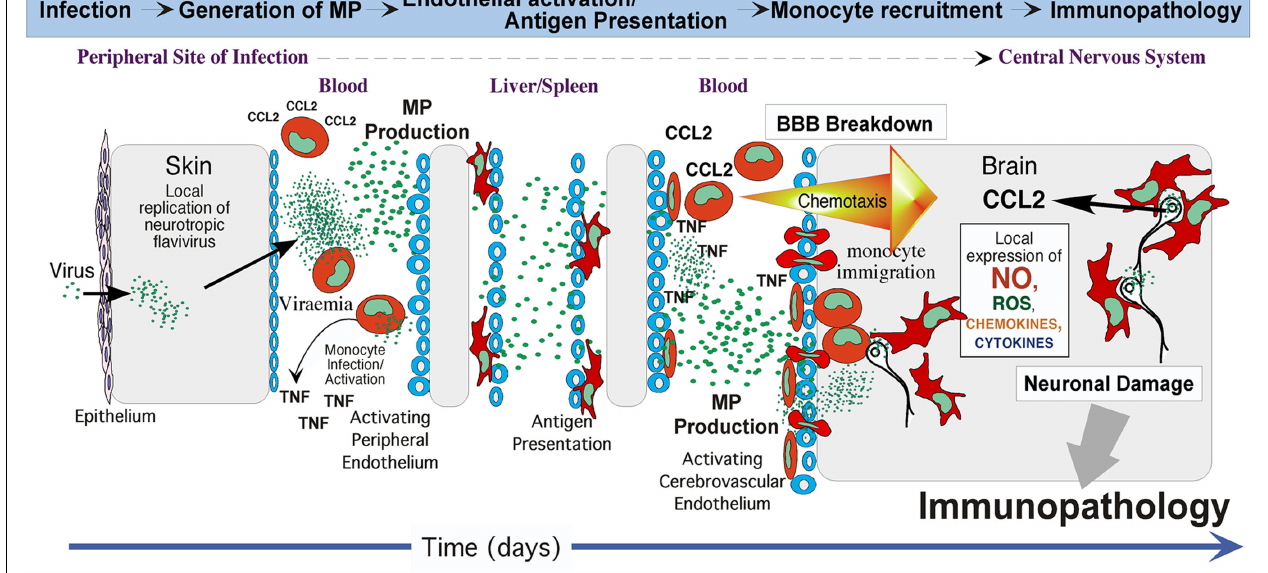
FIGURE 1 | Putative role of MP in immunopathogenesis of flavivirus encephalitis. After local replication of virus at the site of